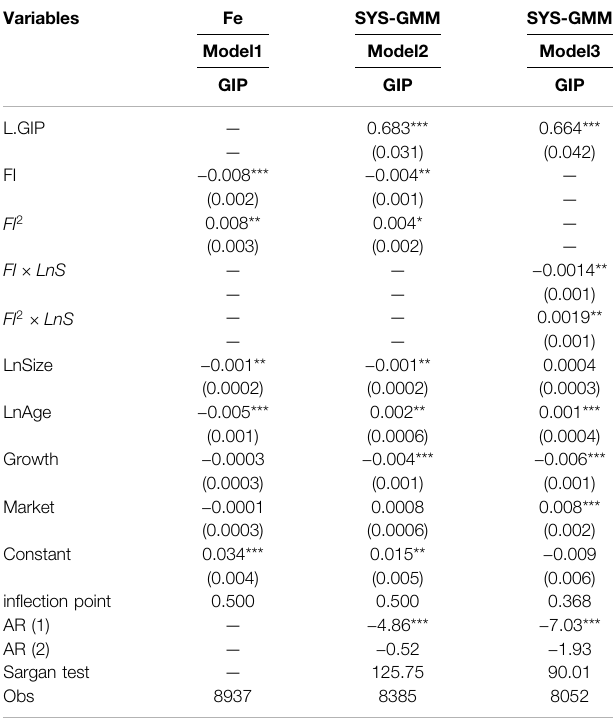
TABLE 4 | Regression on the static and dynamic panel